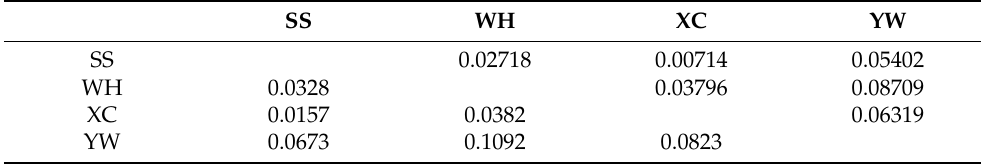
Table 8. Genetic differentiation index (Fst) (above diagonal) and Nei’s genetic distance (below